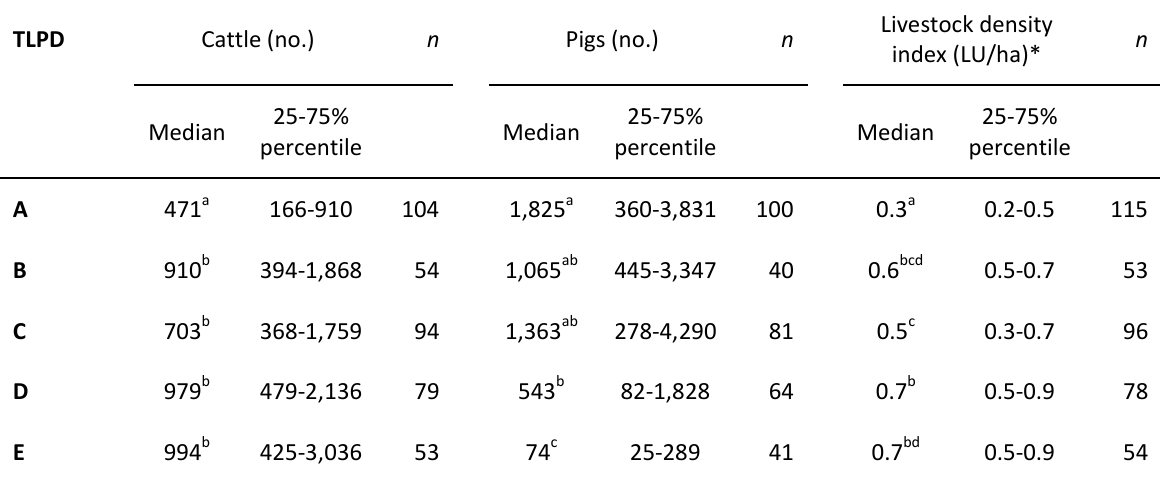
Table 6: Characterisation of types of agricultural land-use patterns and dynamics (TLPD A-E) by livestock numbers for 2010, results of the analysis of